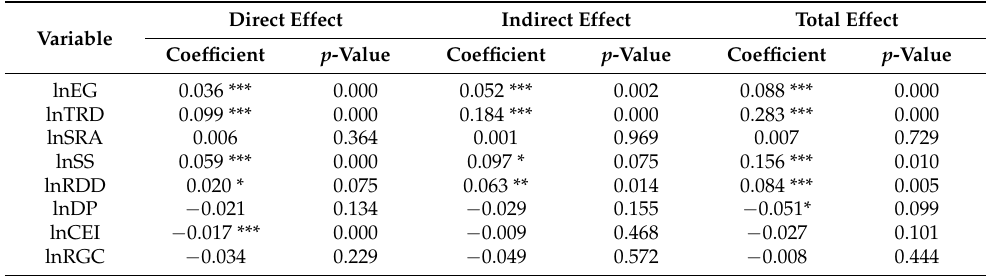
Table 6. Total effect decomposition of the spatial Dubin regression model.